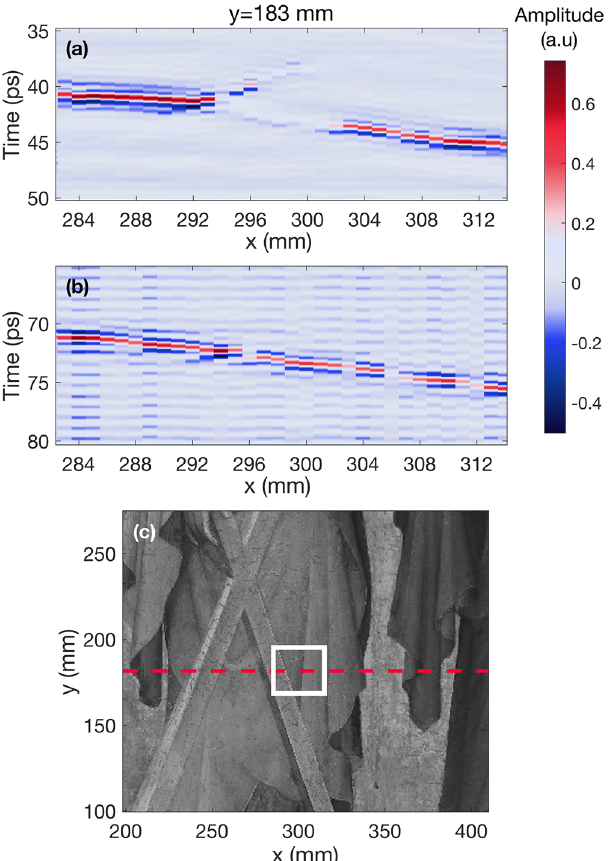
Figure 4. Before and after B-scans along x-axis of ROI 5. ( a ) B-scan taken from before data at y = 183 mm. The lifting of the outer paint from the inner paint layers is visible from x = 294 mm to x = 302 mm. ( b ) B-scan of the same region taken from the THz data after the consolidation. The same region that had become detached now appears homogeneous. ( c ) Close up of the region on the painting where B-scans were taken. The red dotted line indicates the exact location on the y-axis where the data was obtained, and the white rectangle encloses the area shown in the